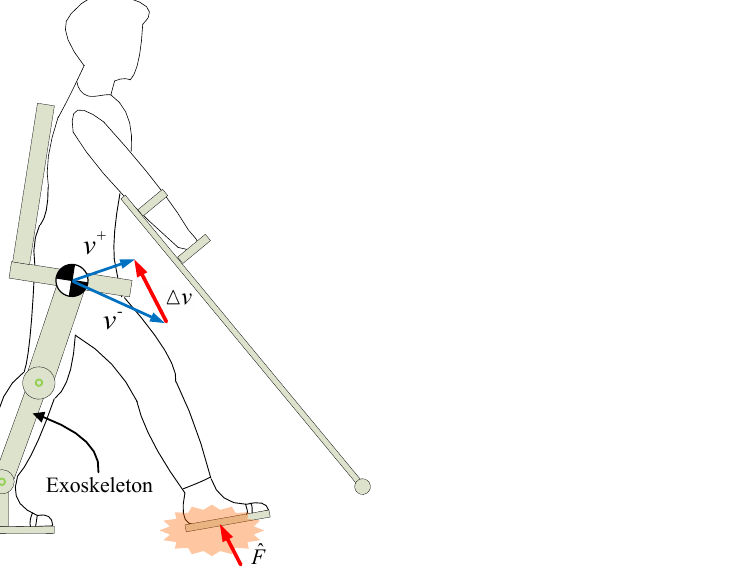
Figure 1. A subject is walking with a lower-limb exoskeleton. The CoM velocity is instantaneously turned from v − to v + when the swing foot strikes, and an impact force acts on the human-exoskeleton system. How to reduce the peak of ground reaction